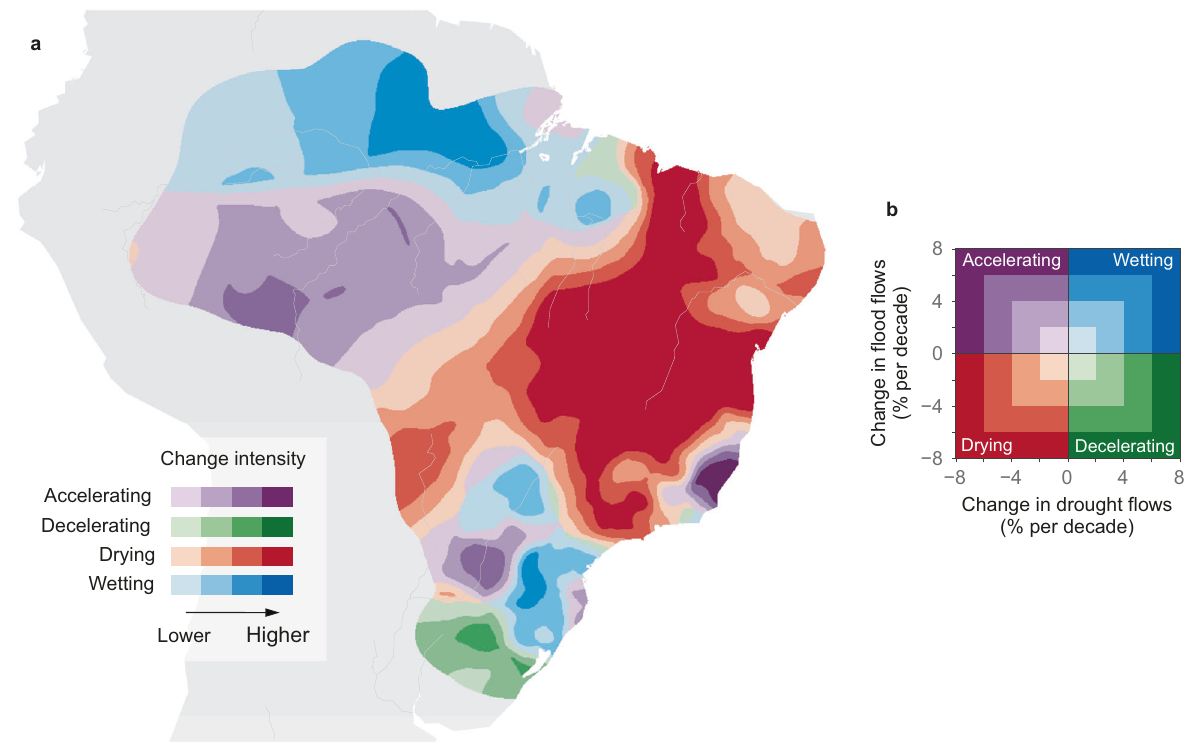
Fig. 5 | Spatial distribution of the accelerating, decelerating, wetting, and drying stream fl ow trends in Brazil. a The location of the four quadrants of regionalstream fl ow trends, with darker colorsindicating largerchange intensities.